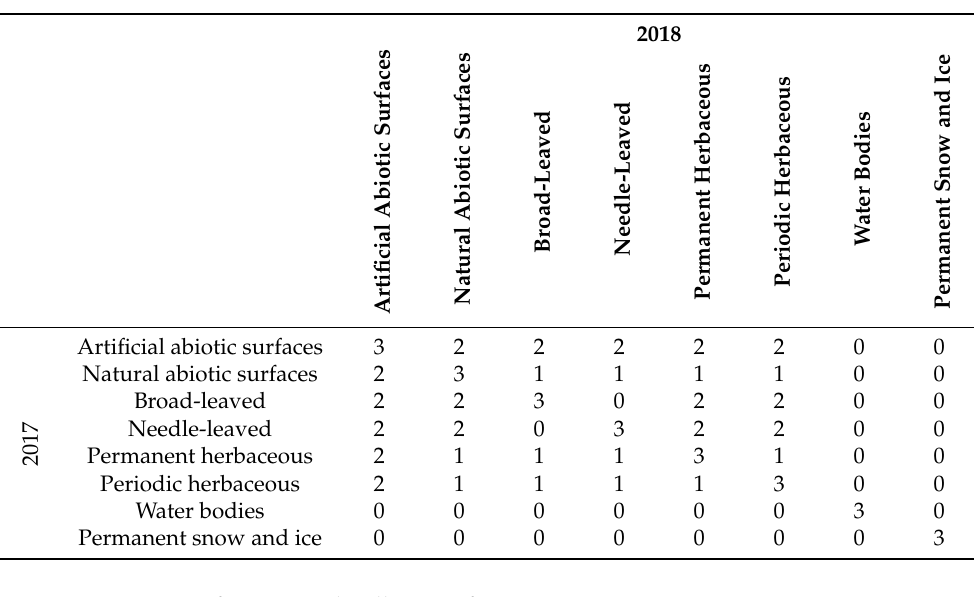
Table 3. Land cover transformation matrix on yearly basis. The following transformations are considered: 3—Likely (Stability), 2—Probable (change can happen any time), 1—Possible (change can happen in specific cases), 0—Not